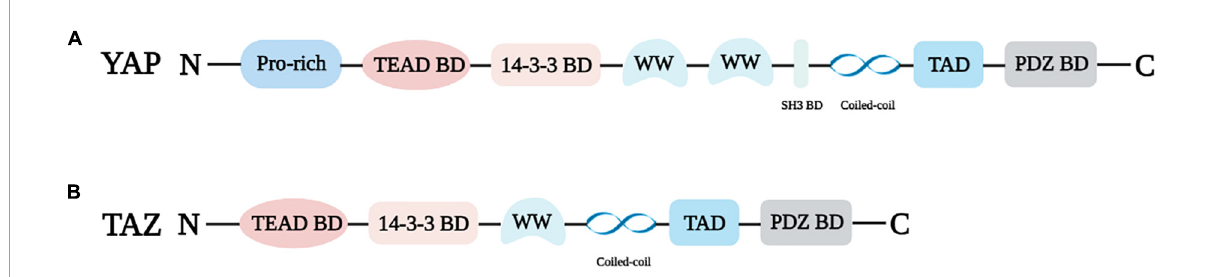
FIGURE1 Structural properties of YAP (A) and TAZ (B) . Pro-rich: Proline-rich; TEAD BD: TEAD binding domain; 14-3-3 BD: 14-3-3 binding domain, WW: WW domain; SH3 BD: SH3 binding domain; PDZ BD: PDZ binding